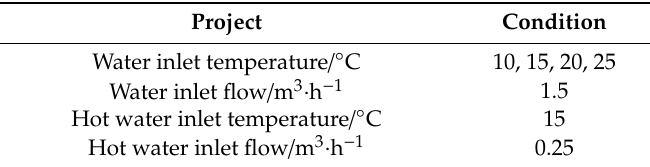
Table 5. Experimental test condition.